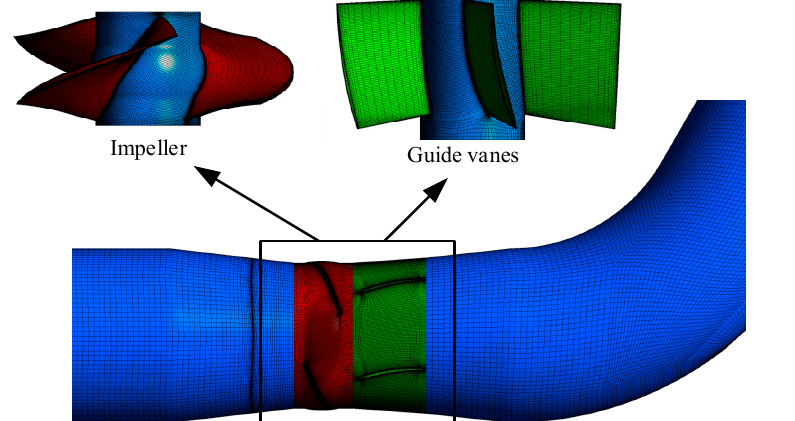
Figure 5. The hexahedral mesh.